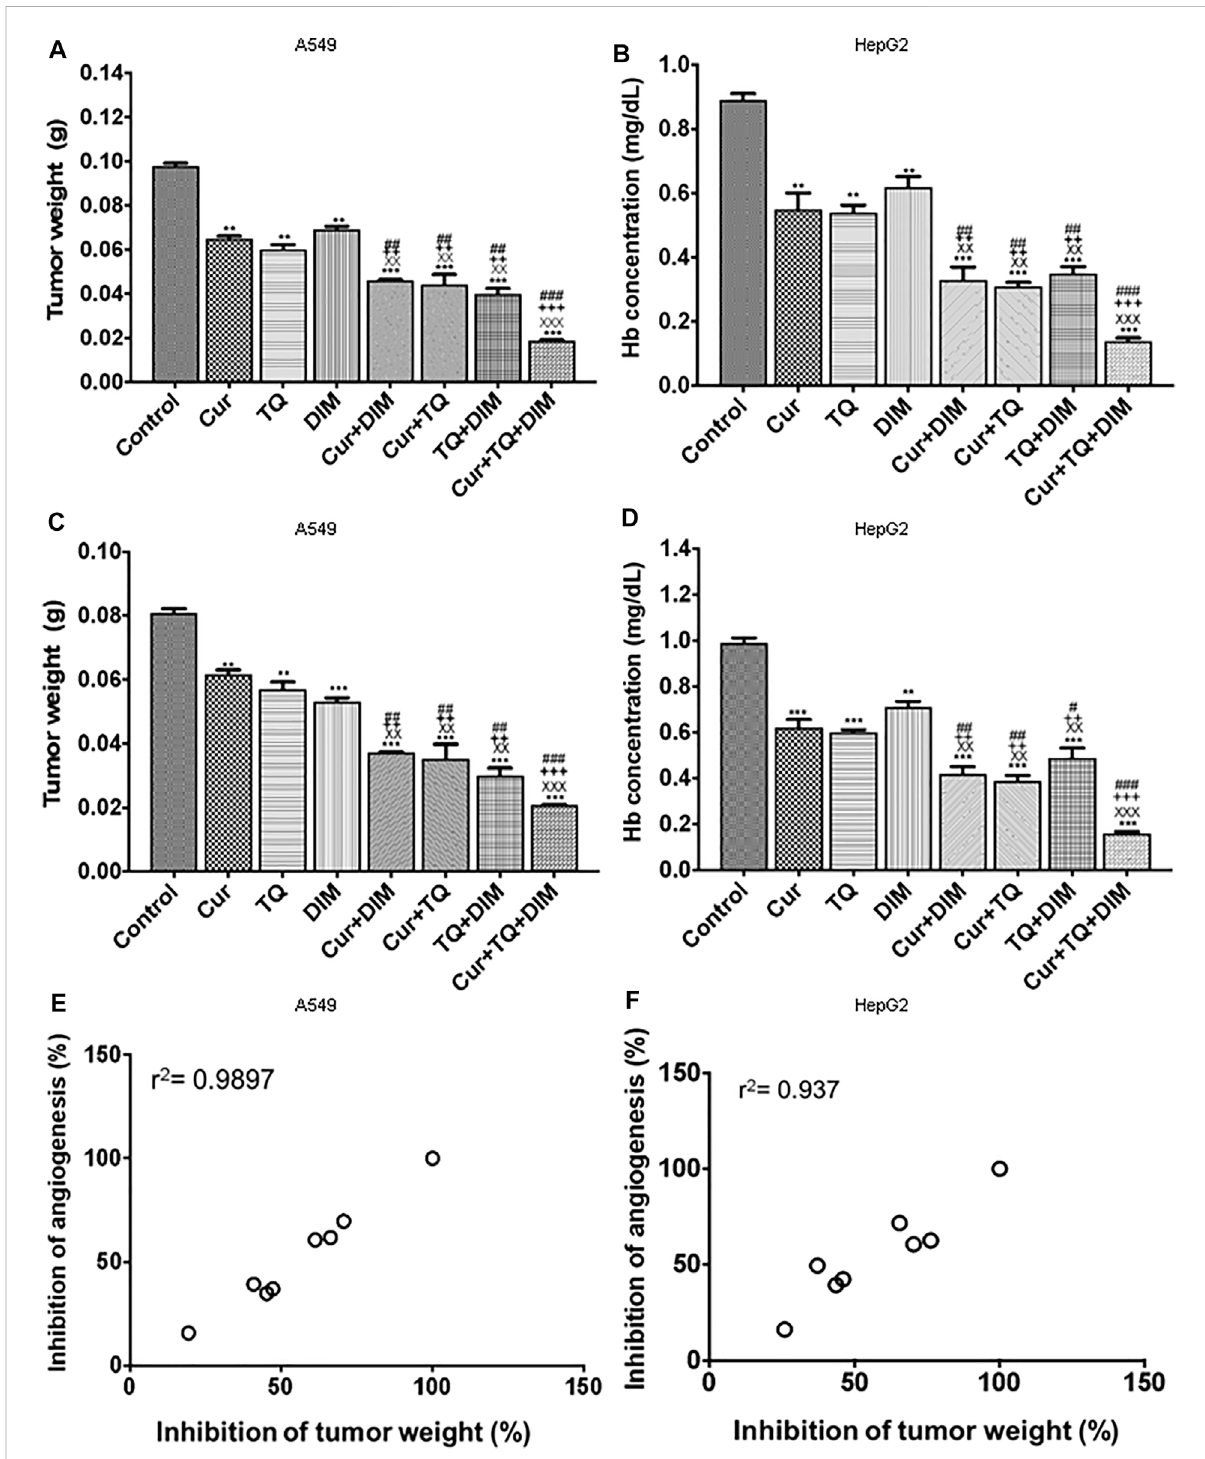
FIGURE 10 Chorioallantoicmembrane (CAM)model. (A) Tumorweight pergfor A549implant (B) Hemoglobinconcentration (mg/ml)for A549 implant (C) TumorweightpergforHepG2implant,and (D) Hemoglobinconcentration(mg/ml)forHepG2implant. (E) Correlationcoef fi cient( r 2 )ofpercentages of inhibition of tumor weight and hemoglobin concentrations for A549 implant. (F) Correlation coef fi cient ( r 2 ) of percentages of inhibition of tumor weight and hemoglobin concentrations for HepG2 implant. The treatment groups were Matrigel with A549 or HepG2 cells (control), Matrigel/ A549 or HepG2 with Cur (3.5 μ g/CAM and 5.8 μ g/CAM), TQ (6 μ g/CAM and 3 μ g/CAM), DIM (11.7 μ g/CAM and 10.4 μ g/CAM), and their combinations of Cur + DIM, Cur + TQ, TQ + DIM, and Cur + TQ + DIM. The data were analyzed with one-way ANOVA followed by Tukey ’ s multiple comparison test. Error bars represent mean ± SD. ** p < 0.01 and *** p < 0.001 vs. control. xx P < 0.01 and xxx P < 0.001 vs. Cur. ++ p < 0.01 and +++ p < 0.001 vs. TQ. # p < 0.05, ## p < 0.01, and ### p < 0.001 vs.